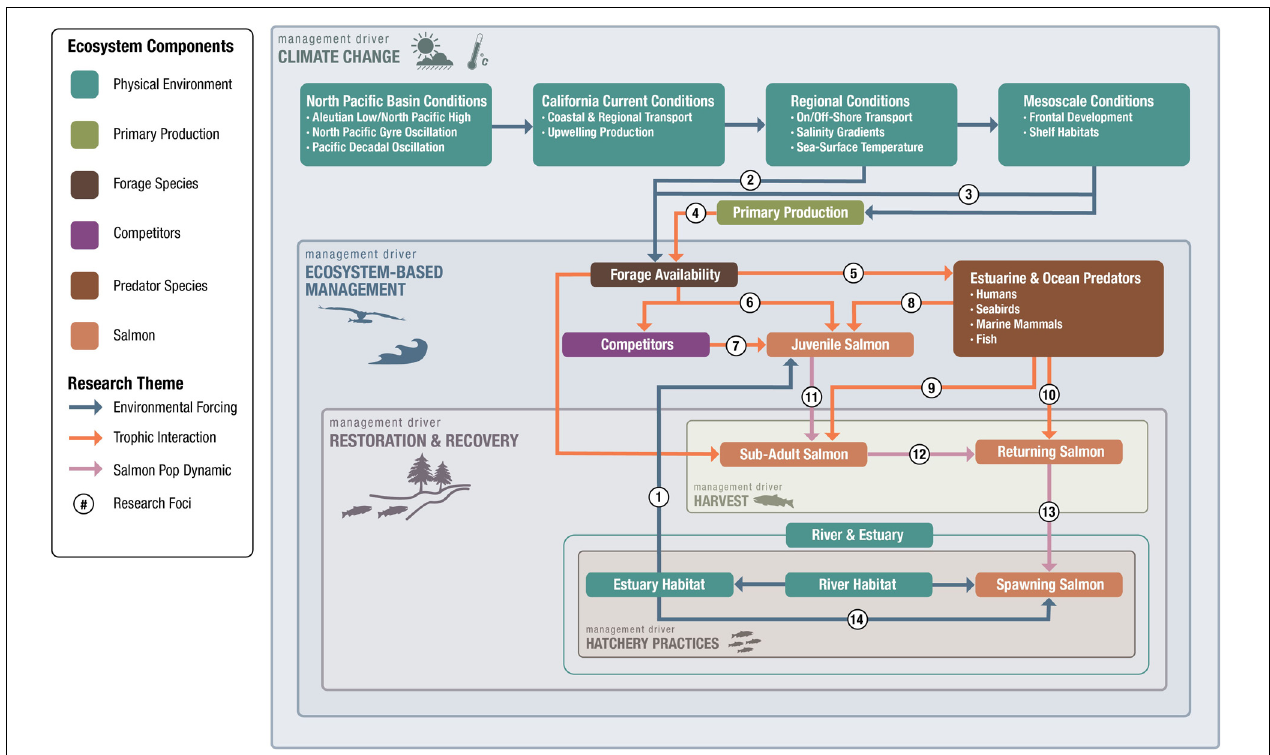
FIGURE 2 | Our first step in answering the question, “What is the fundamental science we need?”, was to develop a conceptual model of ecosystem components that provides a framework for process-related research questions. The conceptual model represents the unidirectional aspects of salmon ocean ecology in which we evaluate the effect of ecosystem components on salmon. First, we identified salmon-ecosystem component categories in the ocean; these are Physical Environment, Primary Production, Forage Community, Predator Species (including humans), and Salmon. Our model also includes linkages among various components that describe their relationships as Environmental Forcing, Trophic Dynamics, or Salmon Population Demographics. Next, we identified the primary management drivers for salmon ocean research and overlaid these so that they overlap the salmon-ecosystem components and linkages that affect them. Our primary management drivers include: Climate Change, Ecosystem-based Management, Salmon Restoration and Recovery, Harvest, and Hatchery Practices. Finally, we listed example research questions (#) that were suggested by the linkages ( Table 1 ). Individual numbers represent specific research areas that should be addressed. Although estuary and river environments are identified in our framework, for the most part we focused on direct linkages with the ocean.